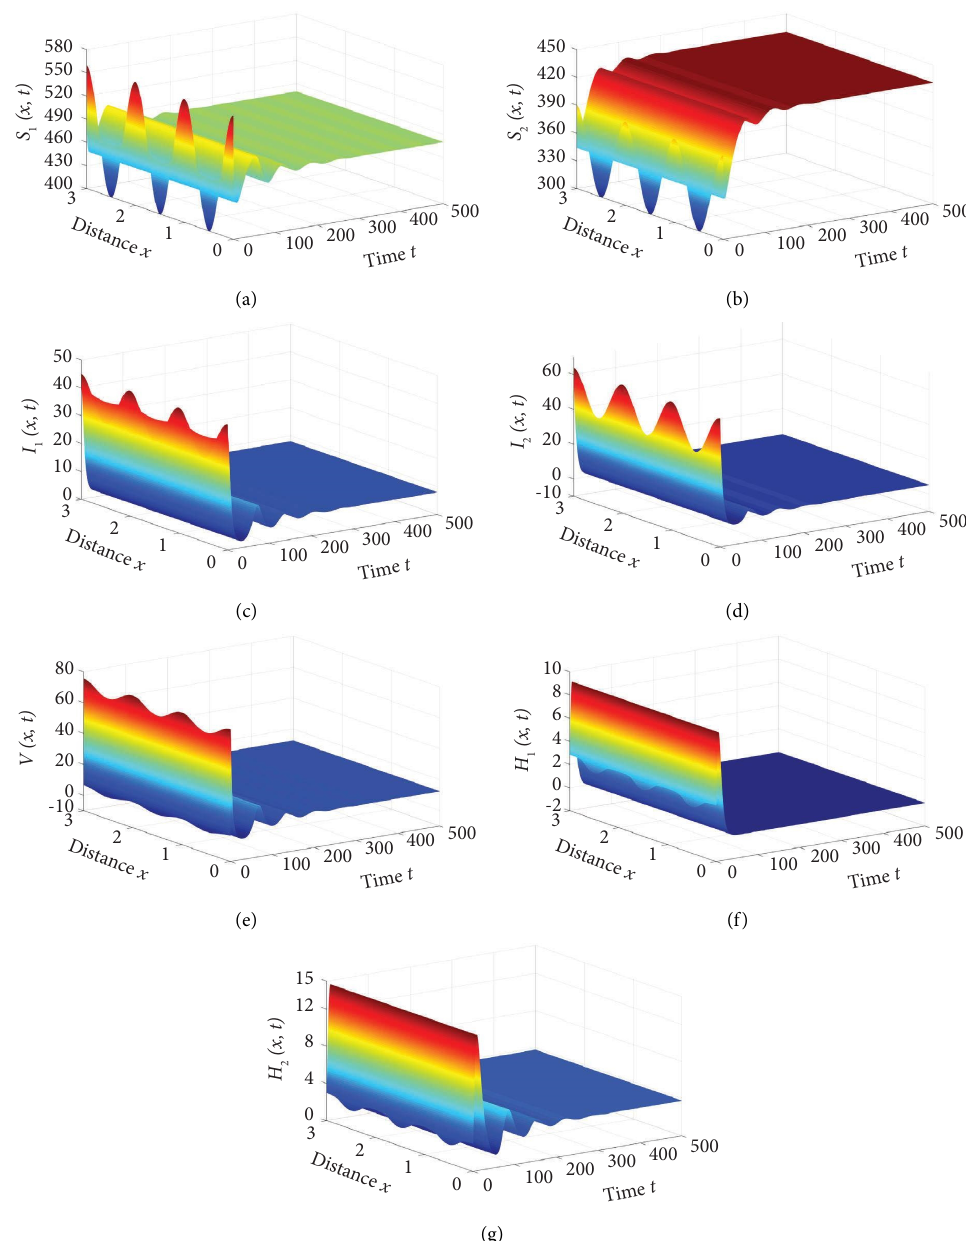
Figure 4: Solution of system (75) with the initial conditions (77), for Case IV. R � ( 480 ., 430 . 7692 , 8 ., 5 . 3846 , 12 . 50 , 0 , 3 . 7897 ) is G.A.S. (a, b) Target cells. (c, d) DENV-infected cells. (e) DENV particles. (f) Heter- Π 3 ologous antibodies. (g) Homologous